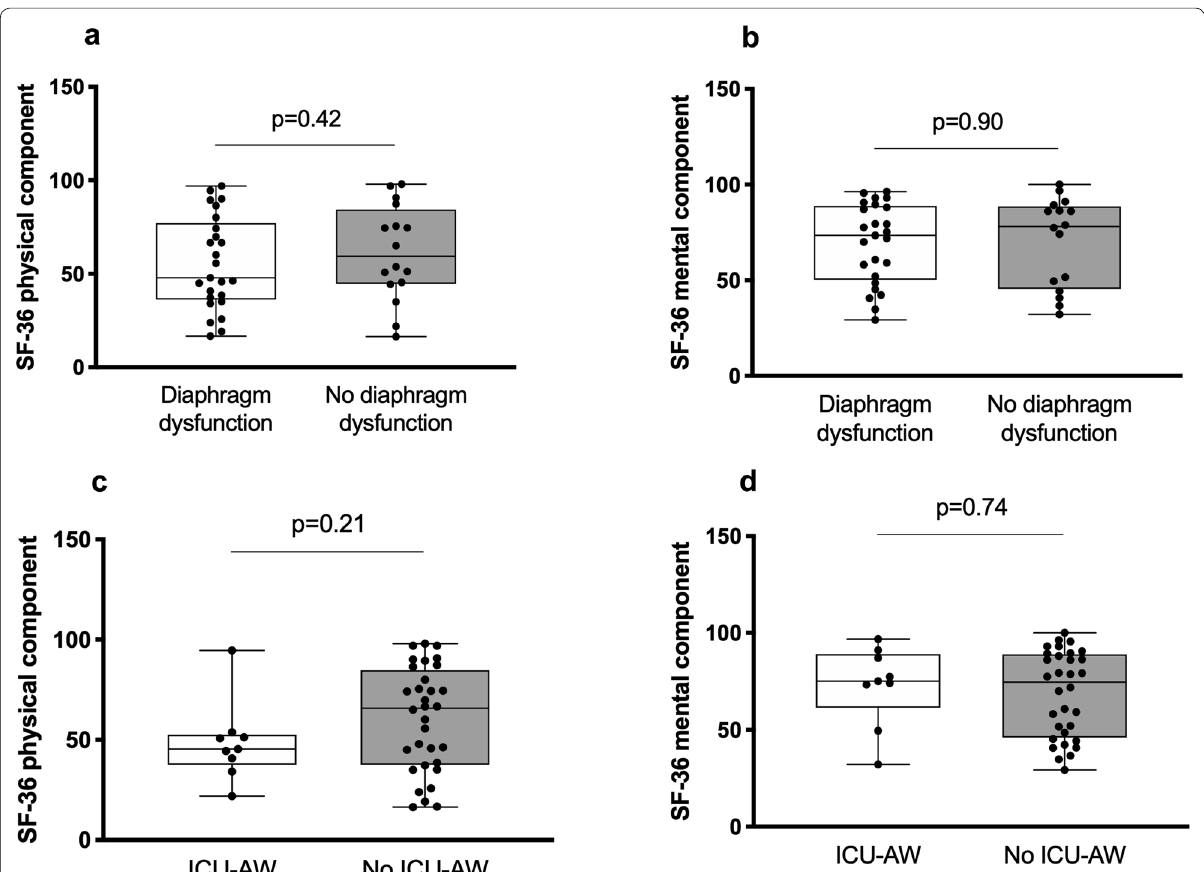
Fig. 4 SF‑36 physical component scores at 2 years among patients with and without diaphragm dysfunction ( a ) and patients with and without intensive care unit‑acquired weakness (ICU‑AW) ( c ) and SF‑36 mental component scores among patients with and without diaphragm dysfunction ( b ) and patients with and without ICU‑AW ( d ) ( n 40 =